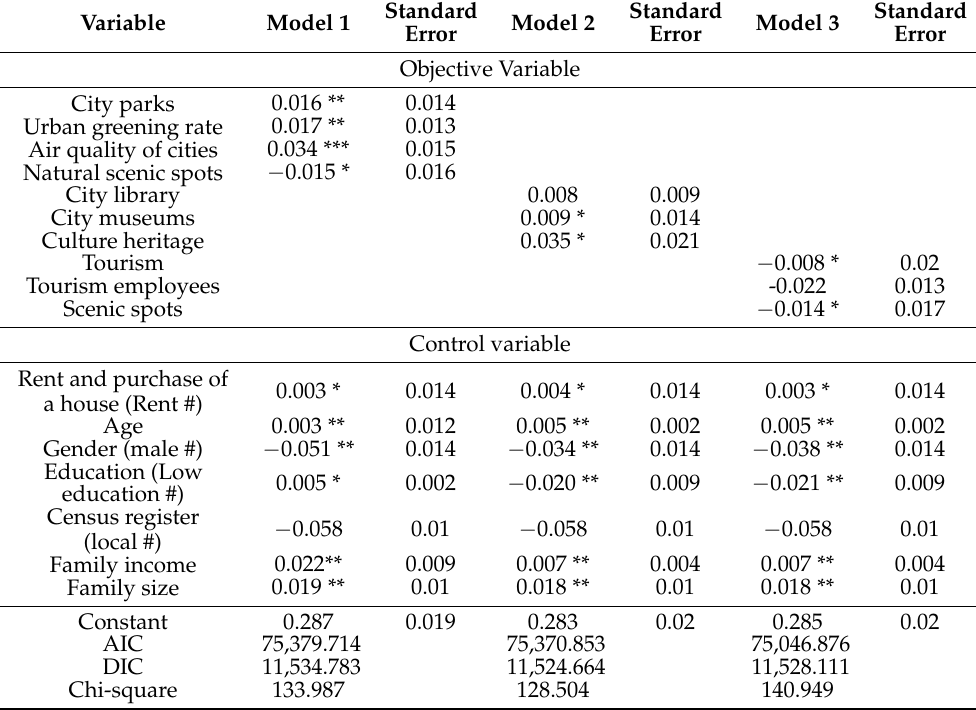
Table 2. Model estimation results with socio-demographics and objective